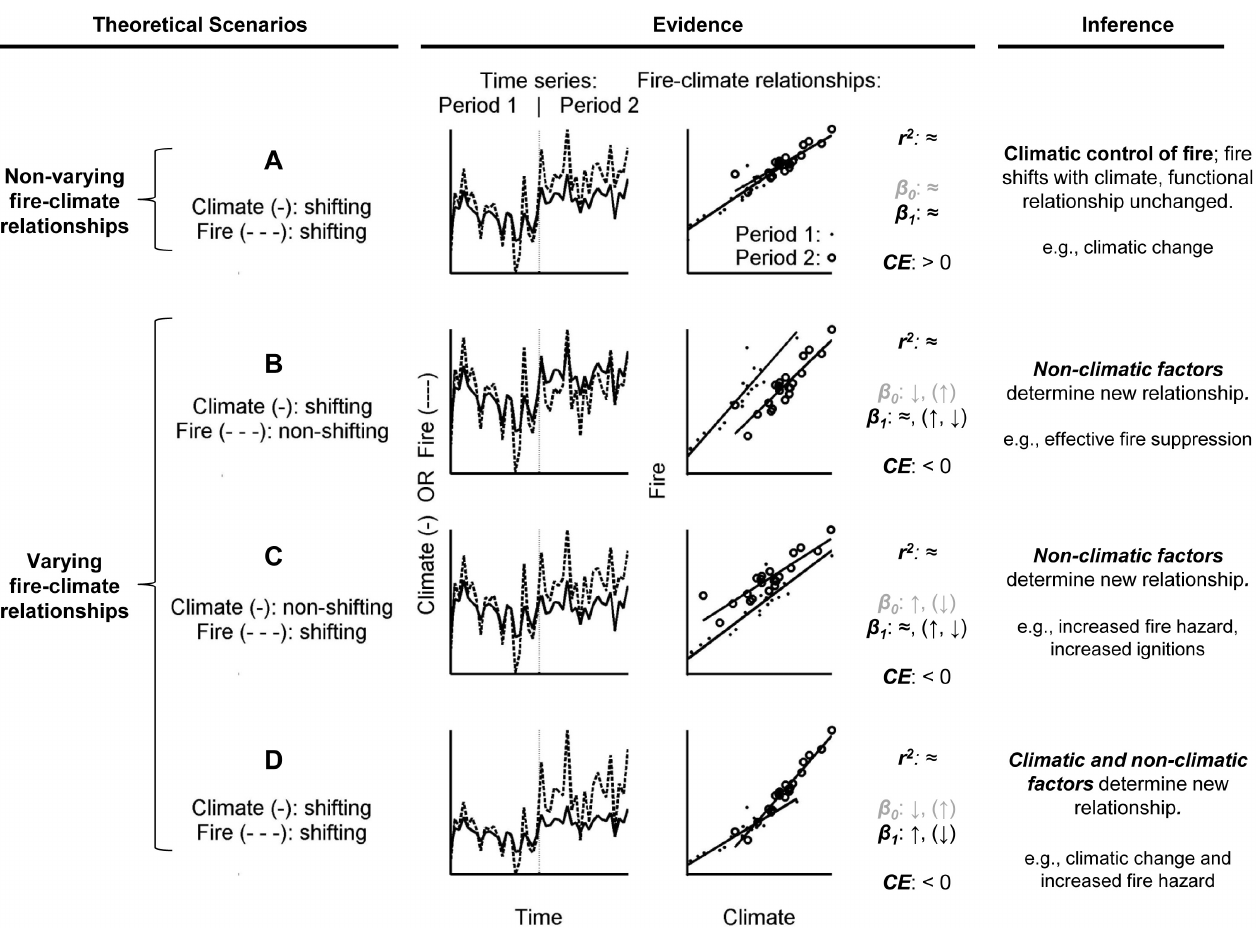
Fig 1. Generalized conceptual model for causes and signatures of shifting fire activity. Scenarios include random variability in “ climate ” (i.e., a hypothetical metric linked to annual fire activity) which directly determines “ fire activity ” (e.g., annual area burned or number of large fires). Period 1 is identical in all scenarios, but the y axes are scaled based on values in Period 2. See “ Introduction ” for a description of each scenario. In all cases of varying fire-climate relationships, a coefficient of efficiency ( CE ) statistic < 0 indicates a lack of predictive skill (for periods outside of the calibration period). β 0 (intercept) and β 1 (slope) represent regression parameters; directional changes in parentheses represent hypothetical scenarios not illustrated in the figure.